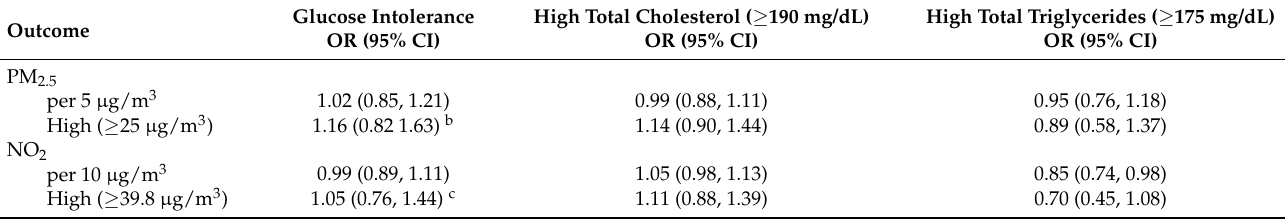
Table 3. Adjusted odds ratios (OR) a and 95% confidence intervals (CI) for the association between PM 2.5 and NO 2 exposure in the first trimester and glucose intolerance (IGT and/or GDM) and elevated serum lipids among women of the INMA Cohort, 2003–2008.